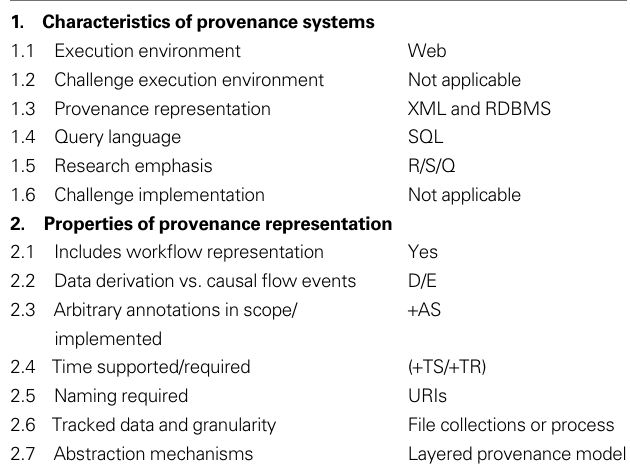
Table 1 | Characteristics of the derived data system with respect to the categorization presented in Moreau et al. (2008), “The First Provenance